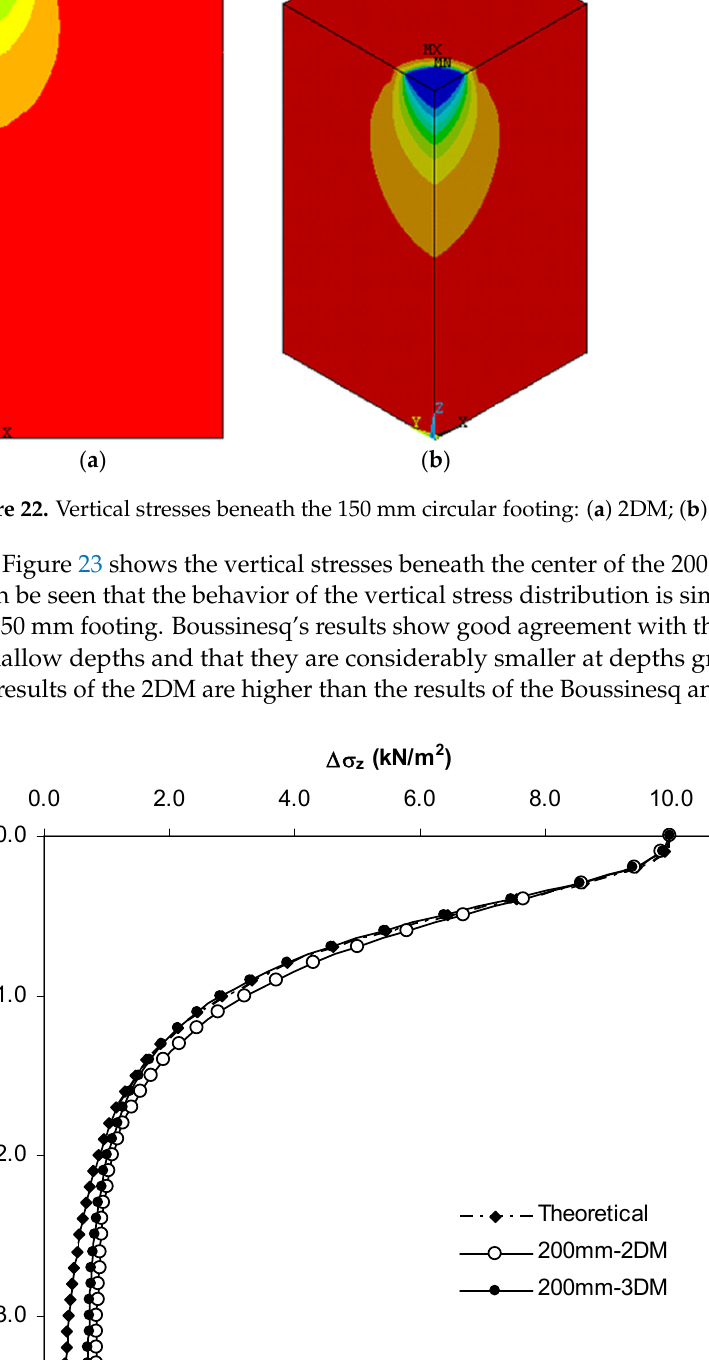
Figure 21. Vertical stress distribution (D = 150 mm).